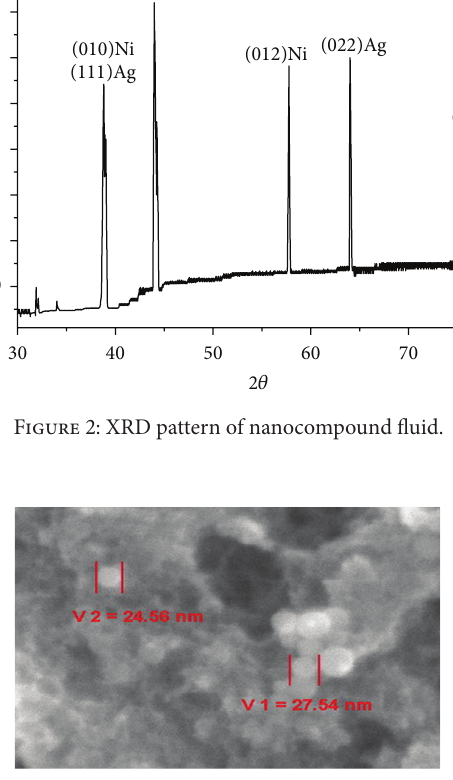
Figure 3: FE-SEM image showing the Ni approach to